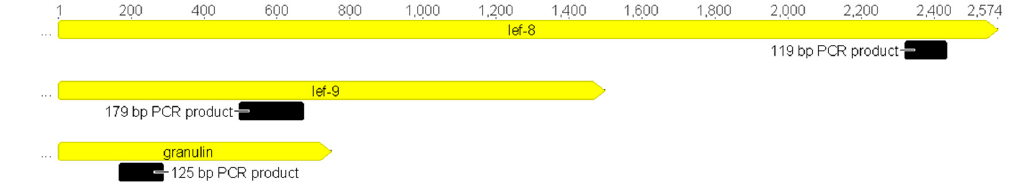
Figure 2. The localization of short fragments amplified in the presented real time PCR method within the granulin , lef-9, and lef-8 genes, using AdorGV as an example.